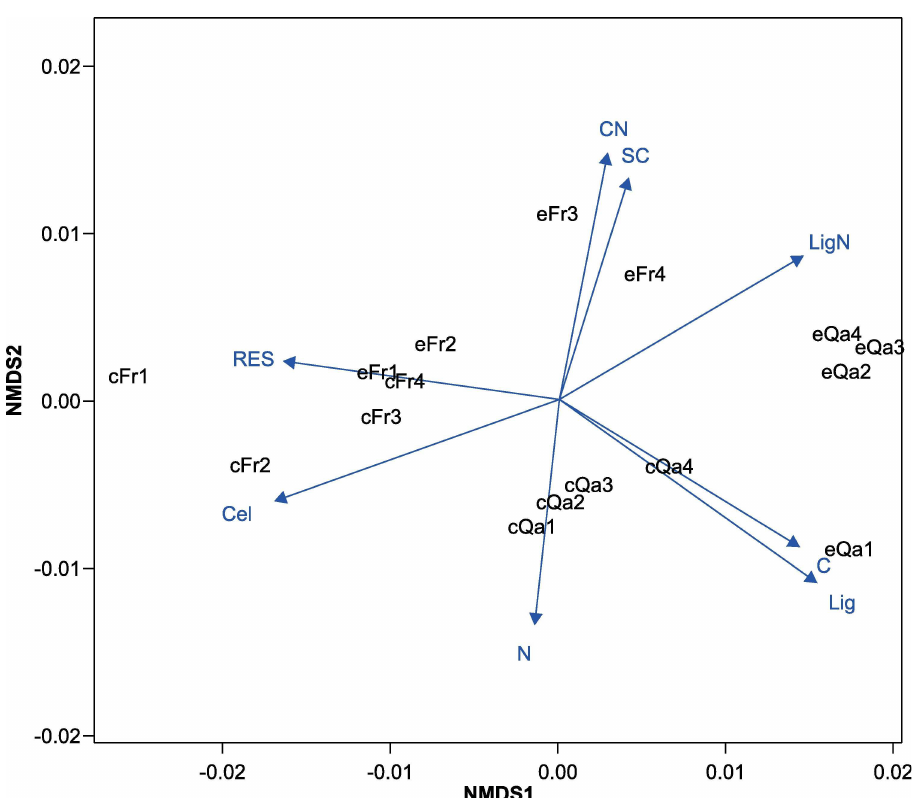
Fig 5. Ordination biplot of NMDS based on the leaf litter decomposition rate of each species. Angles and lengths of the radiating arrows indicate the direction and strength of the relationships of the litter quality parameters. Each vector’s significancelevel was less than 0.05. Carbon (C), nitrogen(N), lignin(Lig), cellulose(Cel), solublecarbohydrate(SC), C/N (CN), lignin/N(LigN), respiration(RES), cQa (ambient CO 2 Q . acutissima group), eQa (elevatedCO 2 Q . acutissima group), cFr (ambient CO 2 F . rhynchophylla group), and eFr (elevated CO 2 F . rhynchophylla